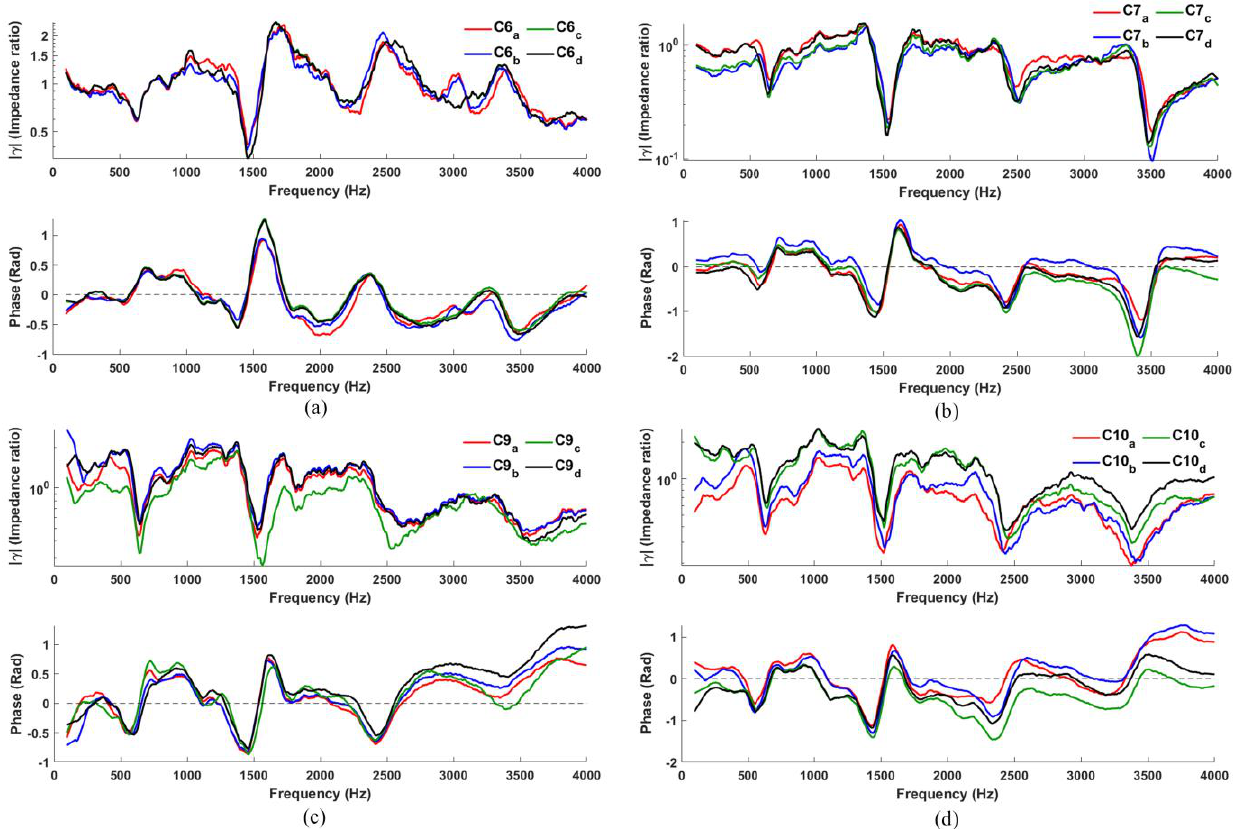
Figure 6. Typical γ (f) measured using configuration: ( a ) C6; ( b ) C7; ( c ) C9; ( d ) C10.